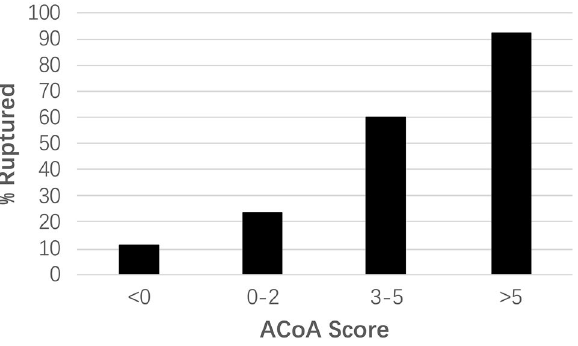
Figure 2. Percent ruptured aneurysms stratified by predictive anterior communicating artery aneurysm score defined in Table